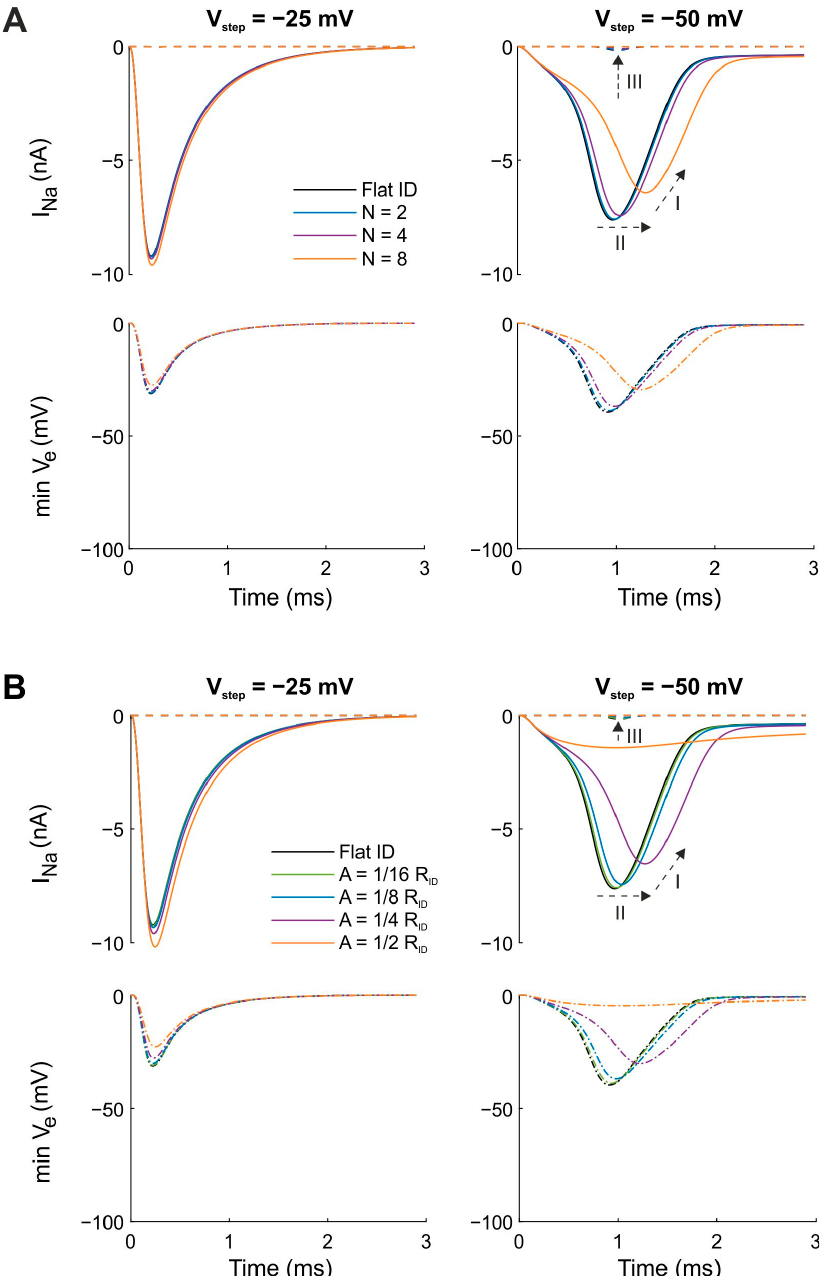
Figure 5. Effects of changing the number N and amplitude A of radial folds on I Na and minimal V e for a uniform distribution of g Na . Contains the same simulations and figure layout as in Figure 2 but now shows results for an intercalated disc mesh with radial folds. ( A ) The amplitude of the folds was kept constant (A = 1/4 R ID ) while the number of folds was varied from 2 to 8. ( B ) The number of folds was kept constant (N = 4) while their amplitude was varied from 1/16 R ID to 1/2 R ID . Dotted arrows: I: self-attenuation of I Na in the pre-junctional membrane; II: self-attenuation and less self-activation in the pre-junctional membrane; III: less self-activation in the post-junctional membrane.